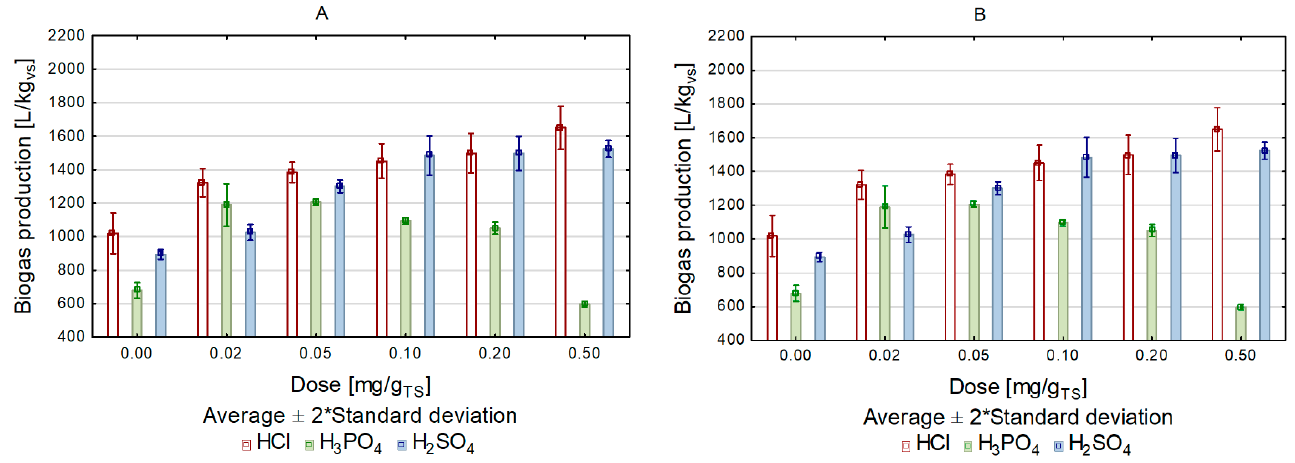
Figure 3. Biogas production depending on the heating method and acid dose (( A )—conventional, ( B )—microwave).